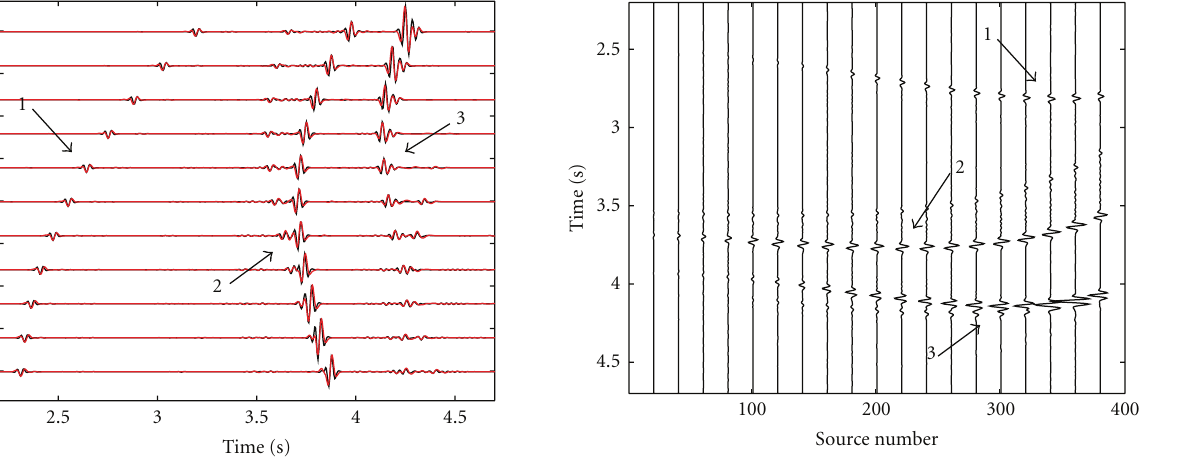
Figure 21: Reference response (black) and the correlation function (red) for a virtual source at x A = (15000m,4000m); reflections 1, 2, and 3 are indicated.